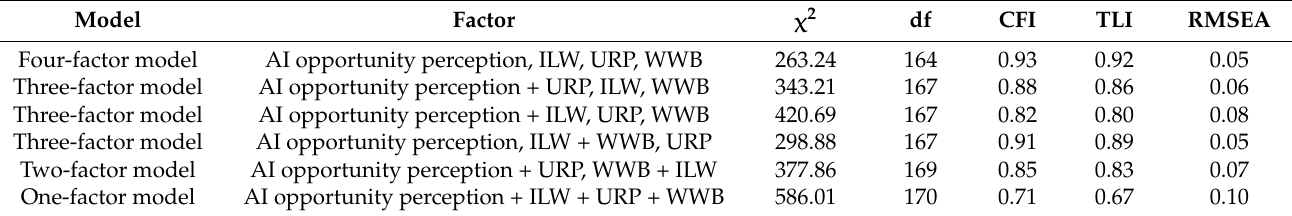
Table 2. Confirmatory factor